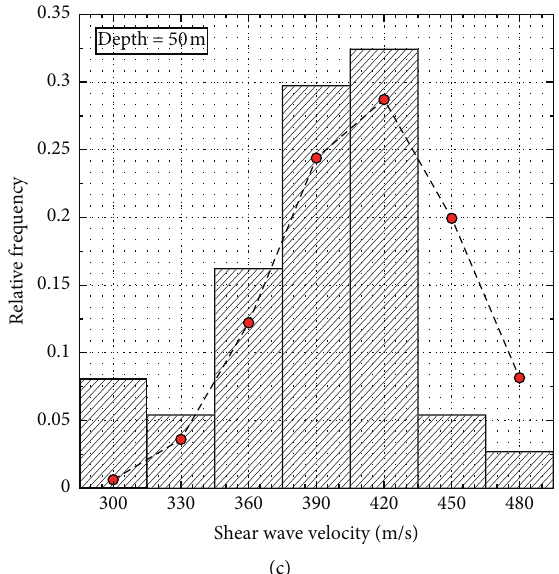
Figure 13: Relative frequency histograms of the shear wave velocities at (a) depth � 10 m, (b) depth � 30 m, and (c) depth � 50m. Normal probability distribution functions shown with dashed lines are superimposed on each histogram.